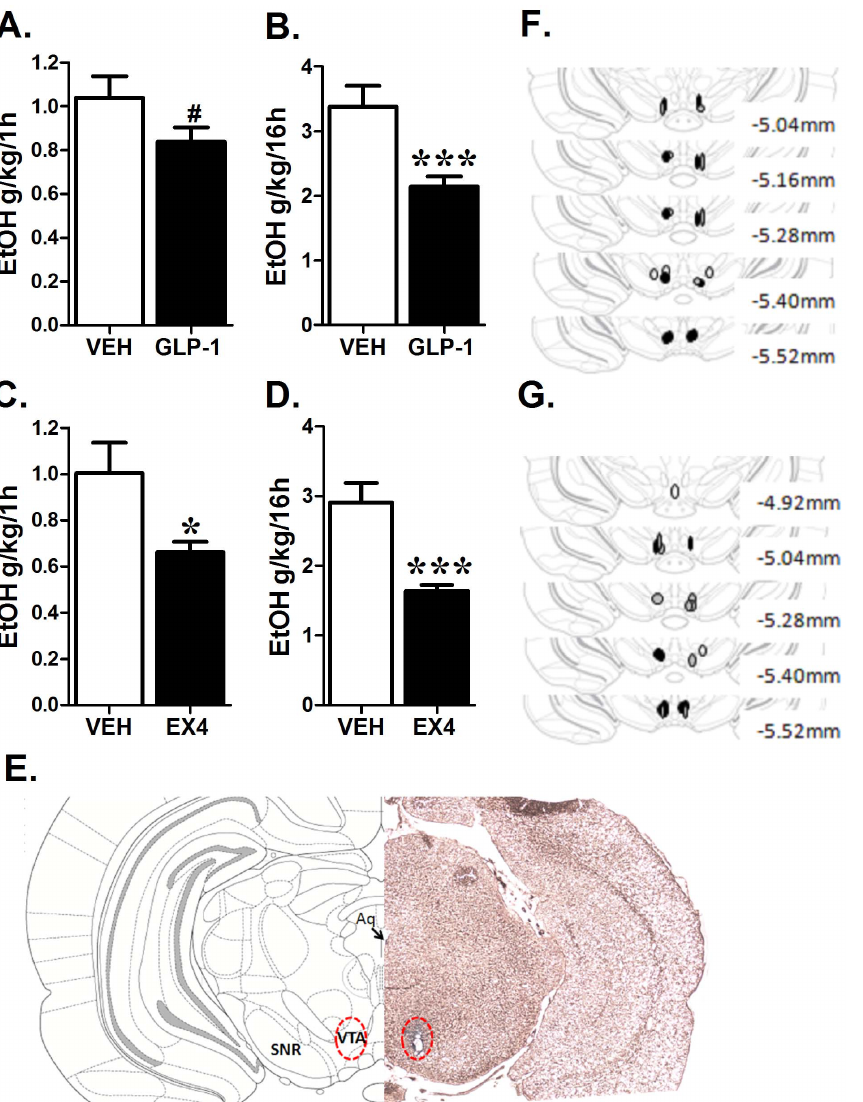
Figure 4. Identification of the mesolimbic VTA as the neuroanatomical substrate for GLP-1R-linked effects on alcohol consumption. VTA-selective unilateral microinjections of GLP-1 (vehicle n=11; GLP-1 1 m g n=7, A 2 B) and EX4 (vehicle n=9; EX4 0.1 m g n=9, C 2 D) reduced 20% ethanol consumption during a 16 h drinking session. A diagram based on Paxinos and Watson at the level of bregma 2 5.40 mm shows a representative VTA injection site (E). Additionally, schematics illustrate the injection site for each rat from the GLP-1 (F) and the EX4 (G) study. Black circles represent vehicle-injected rats, grey drug-injected and white missed placement. All values represent mean 6 SEM. Aq; aqueduct, SNR; substantia nigra pars reticulata . # p , 0.1,*p , 0.05, ***p , 0.005.